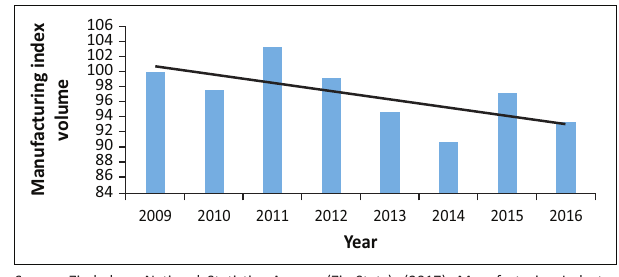
FIGURE 2: Volume of manufacturing index for the Zimbabwe manufacturing sector (2009–2016).